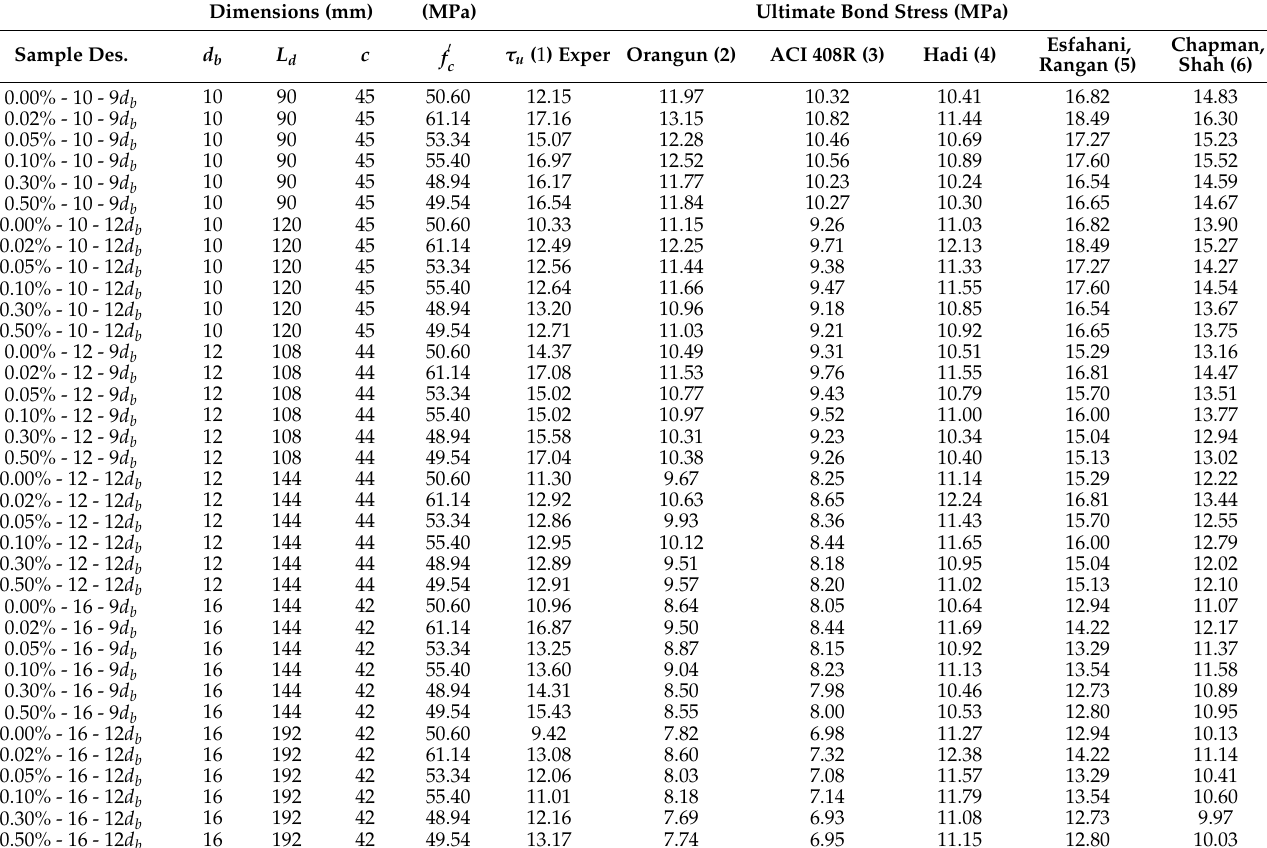
Table 8. The estimated bond stress using prediction equations compared to the bond stress obtained experimentally. Dimensions (mm) (MPa) Ultimate Bond Stress (MPa) Sample Des.